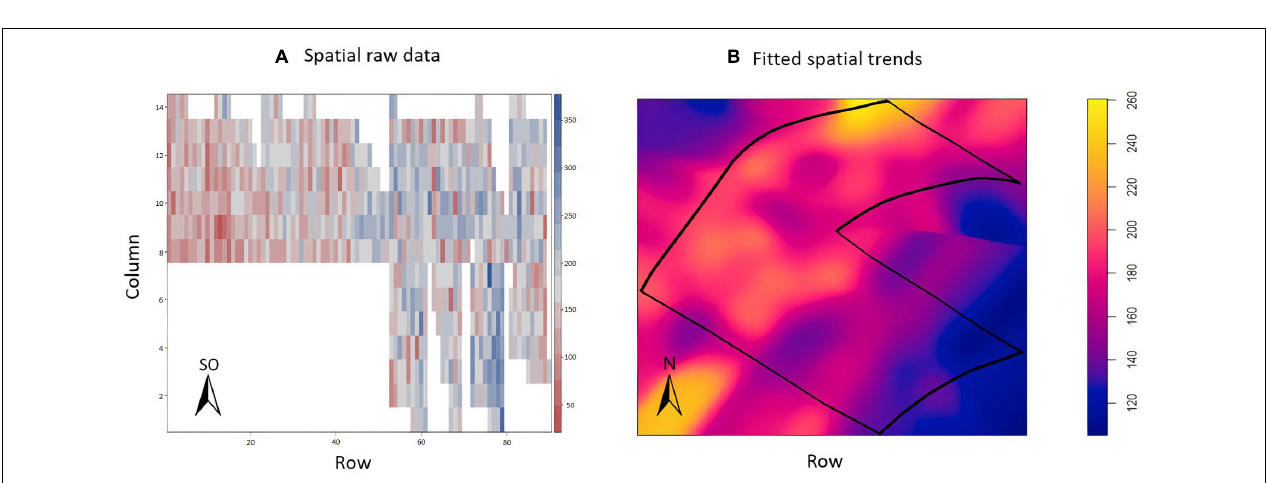
FIGURE 6 | (A) Values of the raw data of tons of cane per hectare (TCH, tons/ha) for each experimental plot (family). (B) Visualization of the spatial pattern of the TCH values, Experimental Area